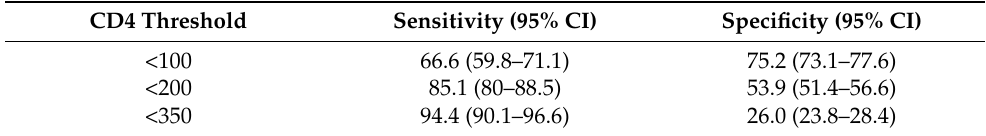
Table 3. CD4 cell counts thresholds. Sensitivity and specificity for OIs screening.